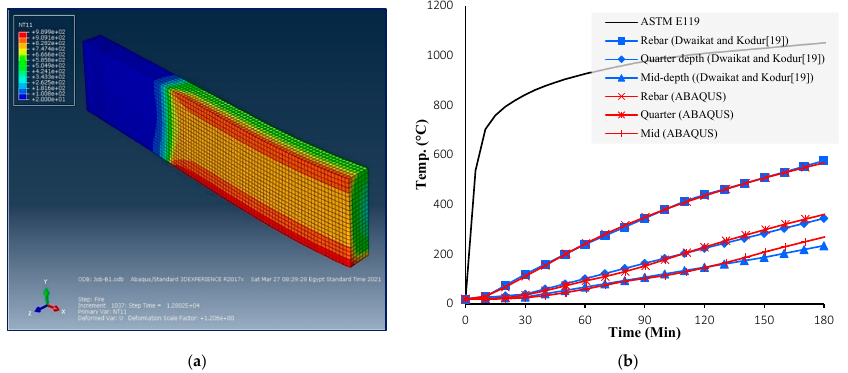
Figure 7. B1 Thermal Response: ( a ) Temperature profile at failure, and ( b ) Predicted and measured cross ‐ sectional temperatures.